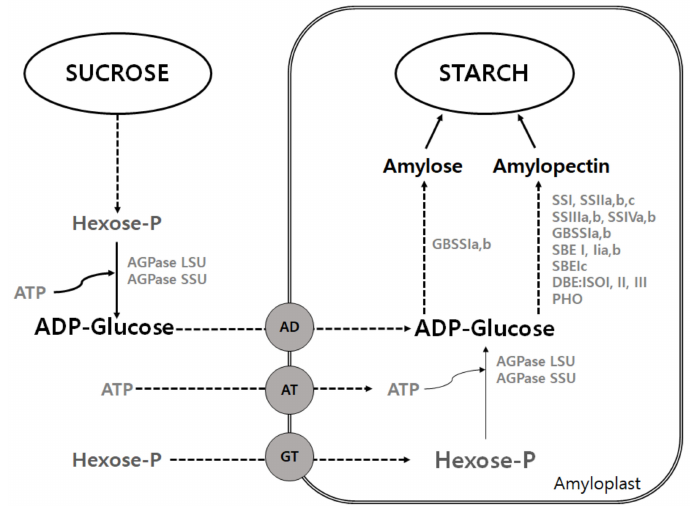
Figure 3. Outlines of starch biosynthesis pathway. ADPglucose pyrophosphorylase (AGPase); AGPase large subunit (AGP-L); AGPase small subunit (AGP-S); ATP/ADPglucose transporter (AD); plastidial ATP transporter (AT); glucose-6-phosphate transporter (GT); starch synthase (SS); granule- bound starch synthase (GBSS); starch branching enzyme (SBE); starch debranching enzyme (DBE); starch phosphorylase (PHO). Source: This is an overview cited in Thitisaksakul et al. [26].